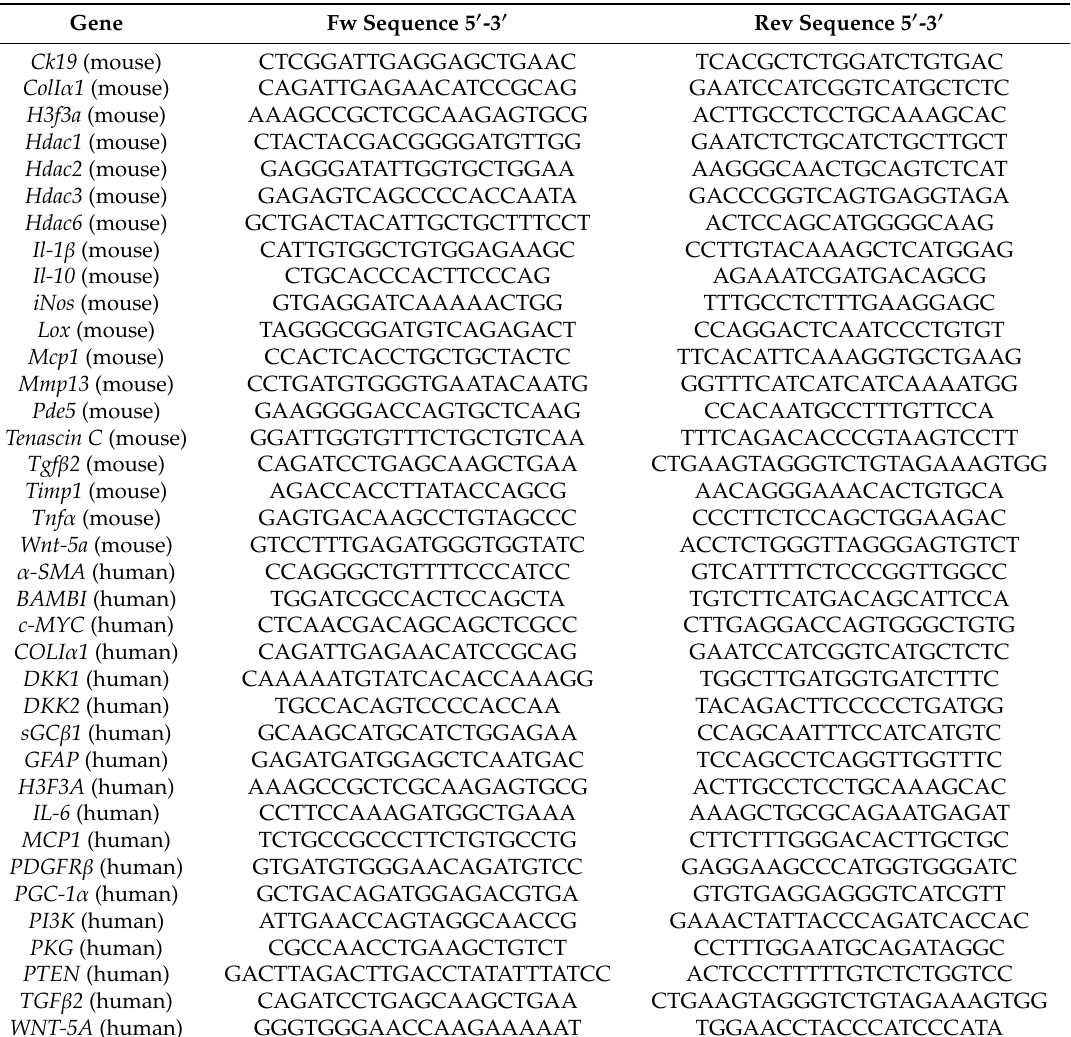
Table A1. List of primers